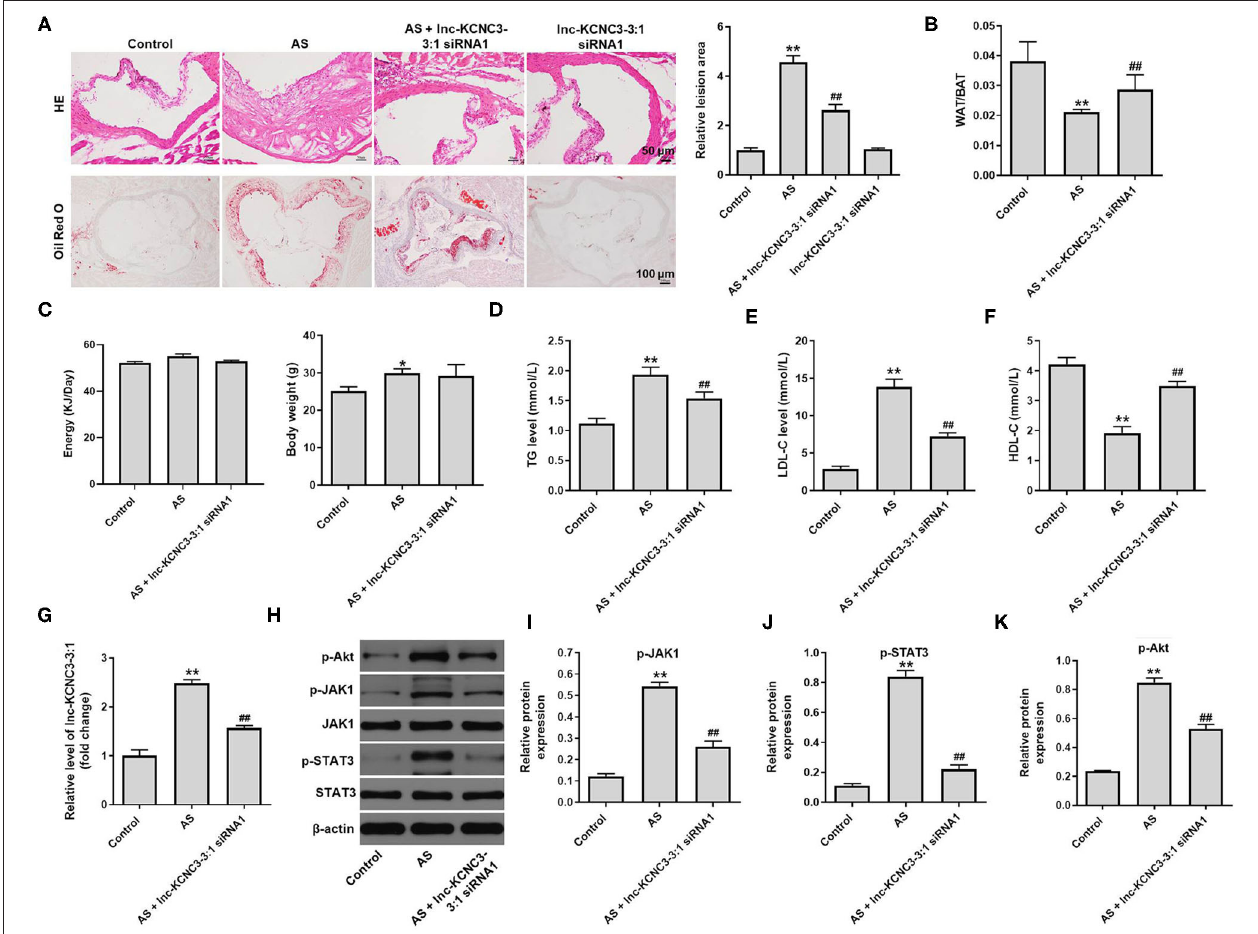
FIGURE 6 | Knockdown of lnc-KCNC3-3:1 alleviates the symptom of atherosclerosis in vivo via downregulation of JAK1/STAT3 signaling pathway. (A) H&E and Oil-red O staining were used to observe the cross section of the aortic root. (B) The WAT/BAT in mice was calculated. (C) The body weight and appetite of mice were detected. (D–F) ELISA assay was used to measure the levels of TG, LDL-C and HDL-C in the plasma of mice. (G) RT-qPCR was performed to measure the level of lnc-KCNC3-3:1. (H–K) Western blot was performed to measure the expression of p-Akt, p-JAK1, JAK1, p-STAT3 and STAT3. ** P < 0.01 compared with control group. ## P < 0.01 compared with the atherosclerosis group, n =